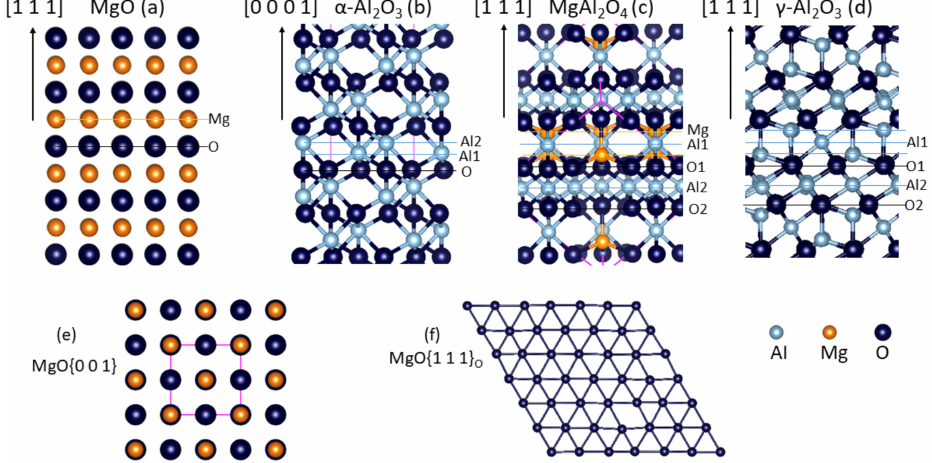
Figure 1. The schematic structures of oxides are composed of alternatively an O layer and a metal layer as shown in (a–d) : Schematic structures for ( a ) MgO along its [1 1 1} orientation, ( b ) α -Al 2 O 3 along its [0 0 0 1], ( c ) MgAl 2 O 4 spinel and ( d ) γ -Al 2 O 3 along their [1 1 1] orientation, and related ( e ) MgO{0 0 1} and ( f ) MgO{1 1 1} O surface. Selected O and metal (sub)layers as potential substrate surfaces in ( a – d ) are also